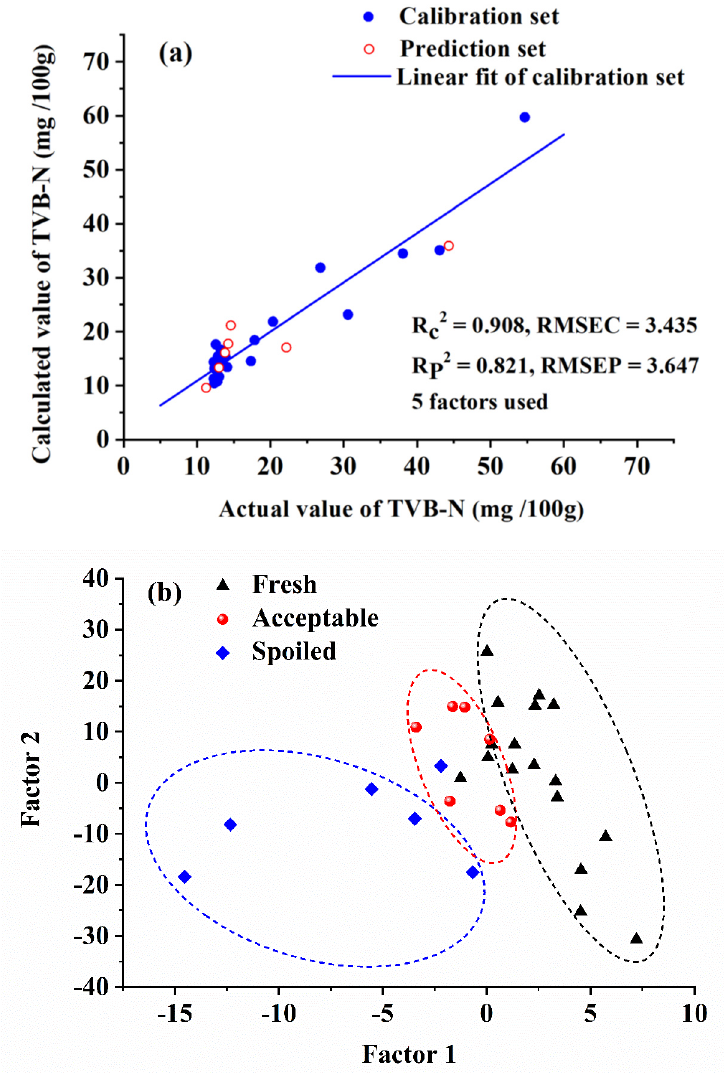
Figure 7. ( a ) The results of PLS modeling of the TVB-N values determined for pork samples during chilled storage. ( b ) The latent variable scores of PLS-DA modeling of pork samples (classified as fresh, acceptable or spoiled).